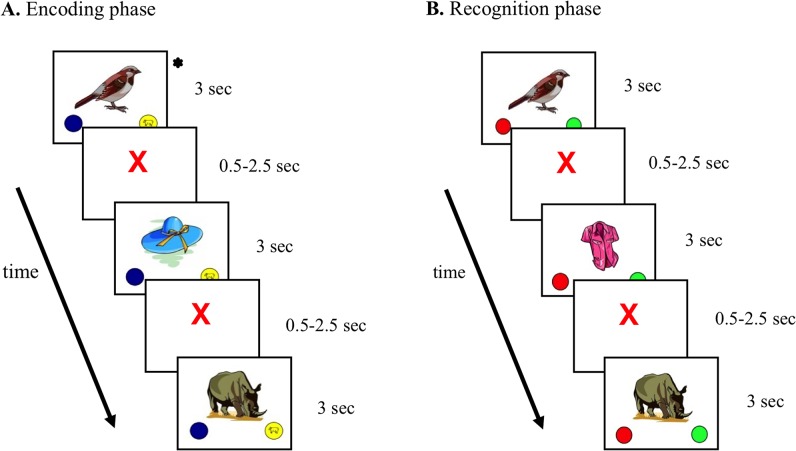
Design of picture encoding and memory task.(A) The encoding phase consisted of two runs with 30 novel and two recurring overlearned pictures (bird and shoe; presented 13 times), derived from the dummy memory disc which the child practiced at home. Children had to indicate whether the stimuli was an animal or object, while fMRI was administrated. (B) The recognition phase, administrated on a personal desktop computer, presented two times 30 pictures earlier presented in the encoding phase, 26 times two overlearned pictures (bird and shoe) and 60 novel pictures. Children had to decide whether or not the stimuli was earlier presented during the encoding phase. In both phases pictures were presented in random order during 3.0 seconds each, followed by a randomized interstimulus interval of 0.5–2.5 seconds during which a red fixation cross was presented. * Overlearned picture (bird or shoe), used to establish a functional baseline (fMRI)